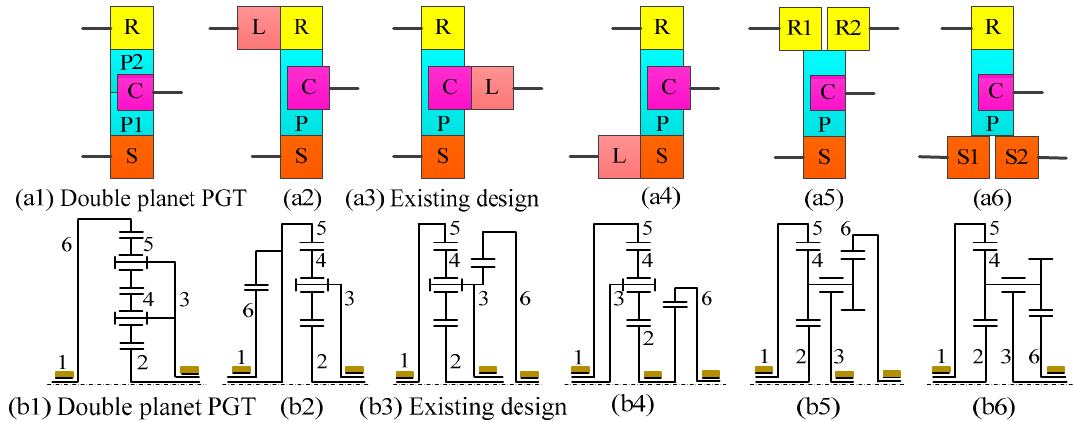
Figure 5. Process of specialization.